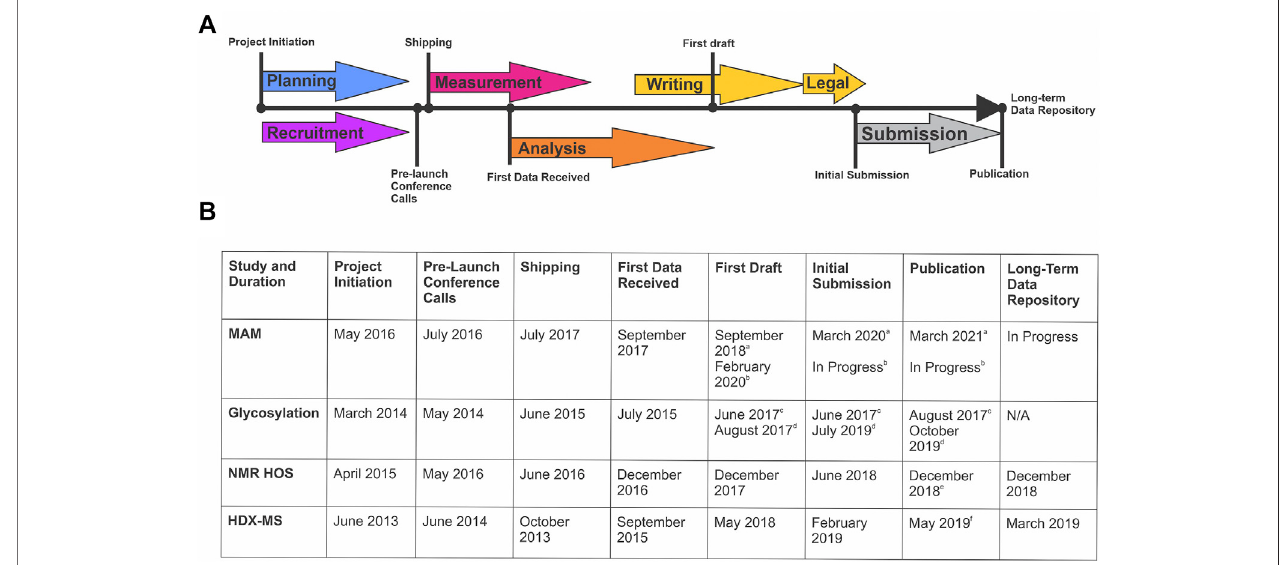
FIGURE 1 | Timeline of Global NISTmAb Interlaboratory Studies. (A) Representative timeline identifying the key milestones for an interlaboratory study. (B) Corresponding dates and key milestones for each NISTmAb interlaboratory study (MAM, glycosylation, NMR HOS, and HDX-MS). a MAM New Peak Detection Publication(Mouchahoiretal.,2021). b MAMAttributeAnalyticsPublication(Inprogress). c GlycosylationInteragencyInternalReport(DeLeozetal.,2017). d Glycosylation InterlaboratoryPublication(DeLeozetal.,2020). e NMRHOSInterlaboratoryPublication(Brinsonetal.,2019). f